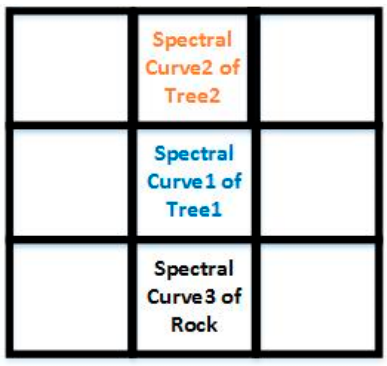
Figure 4. Spectral curve of ground objects.